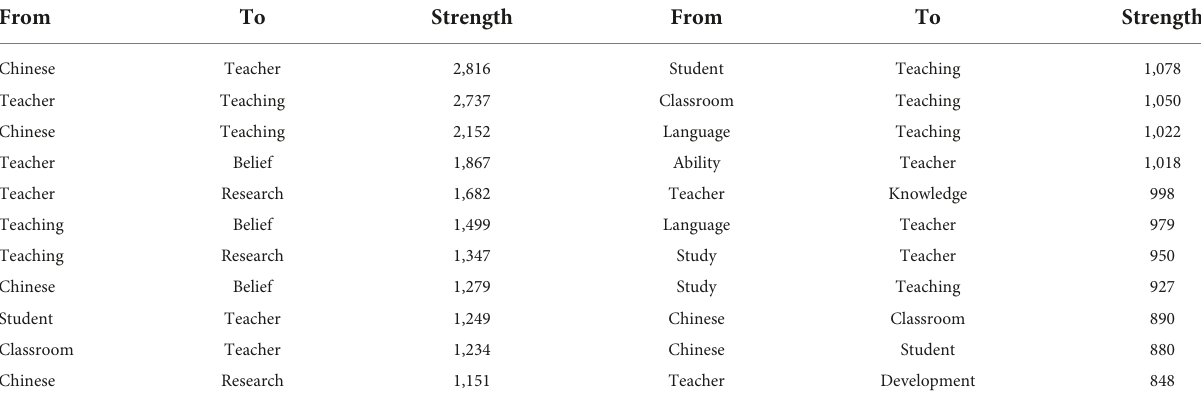
TABLE 1 Semantic network connection strength. From To Strength From